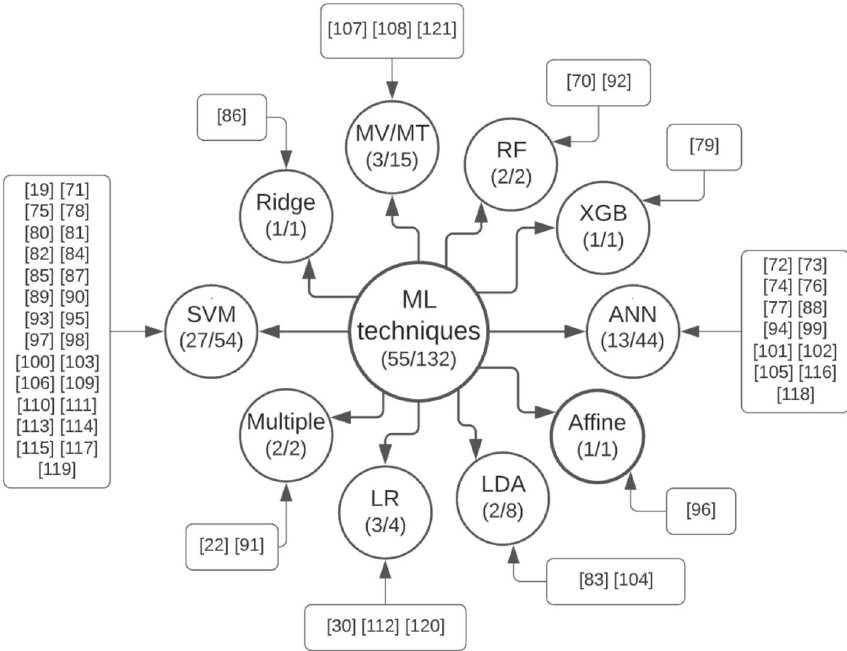
Figure 3. Conceptual map of ML techniques used throughout the articles selected for meta-analysis (number of articles/number of samples). Created with Lucidchart Free https:// www. lucid chart.